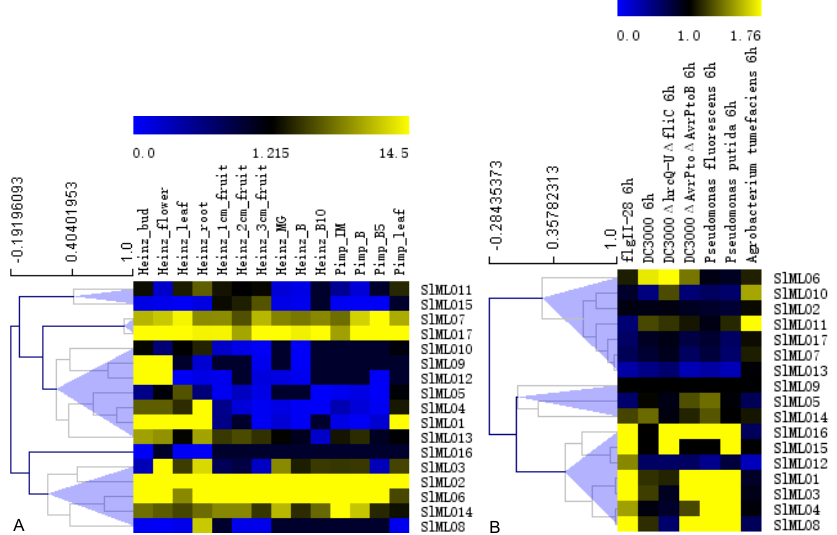
Figure 4. The expression of 17 SlMLO genes in di ff erent tissues ( A ) and under pathogen infection ( B ). ( A ) Expression in tomato cultivar Heinz and Solanum pimpinellifolium . MG, mature green; IM, immature green; B, breaker; B5, breaker + 5; B10, breaker + 10. ( B ) Expression in tomato leaves treated with di ff erent bacteria and